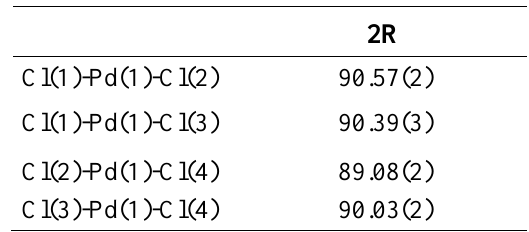
Table 3. Selected Bond Angles (°) for salt 2R .